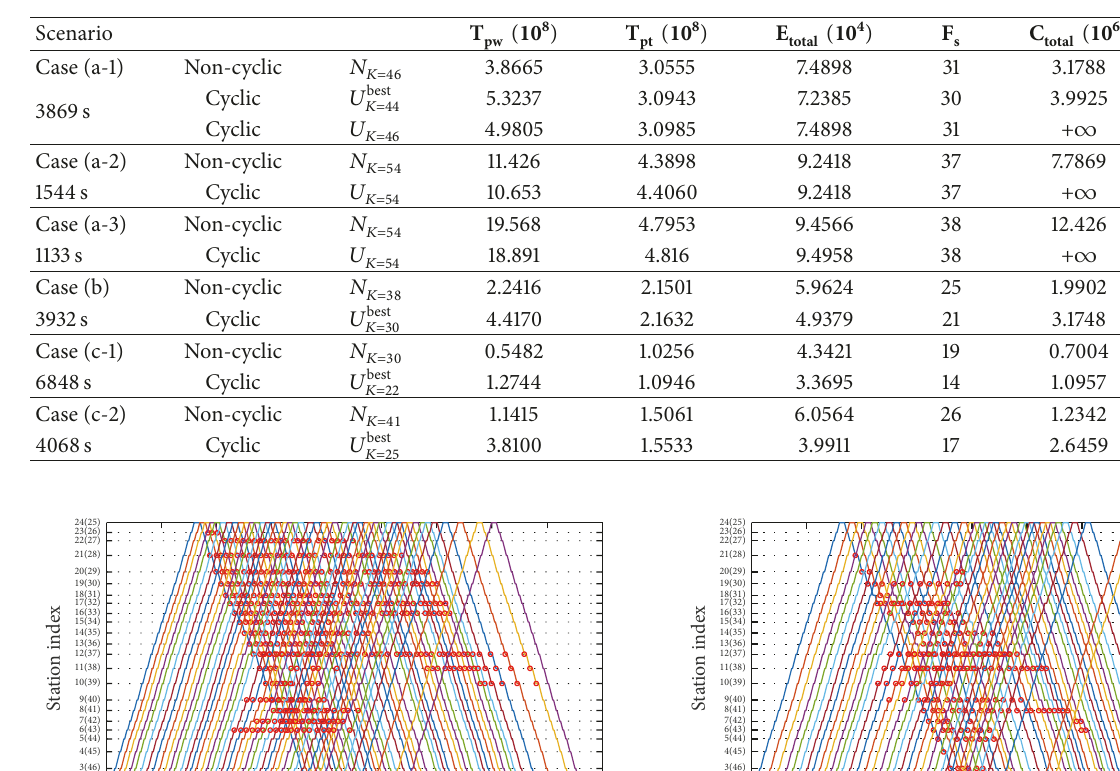
Table 8: Computational results for BML4.